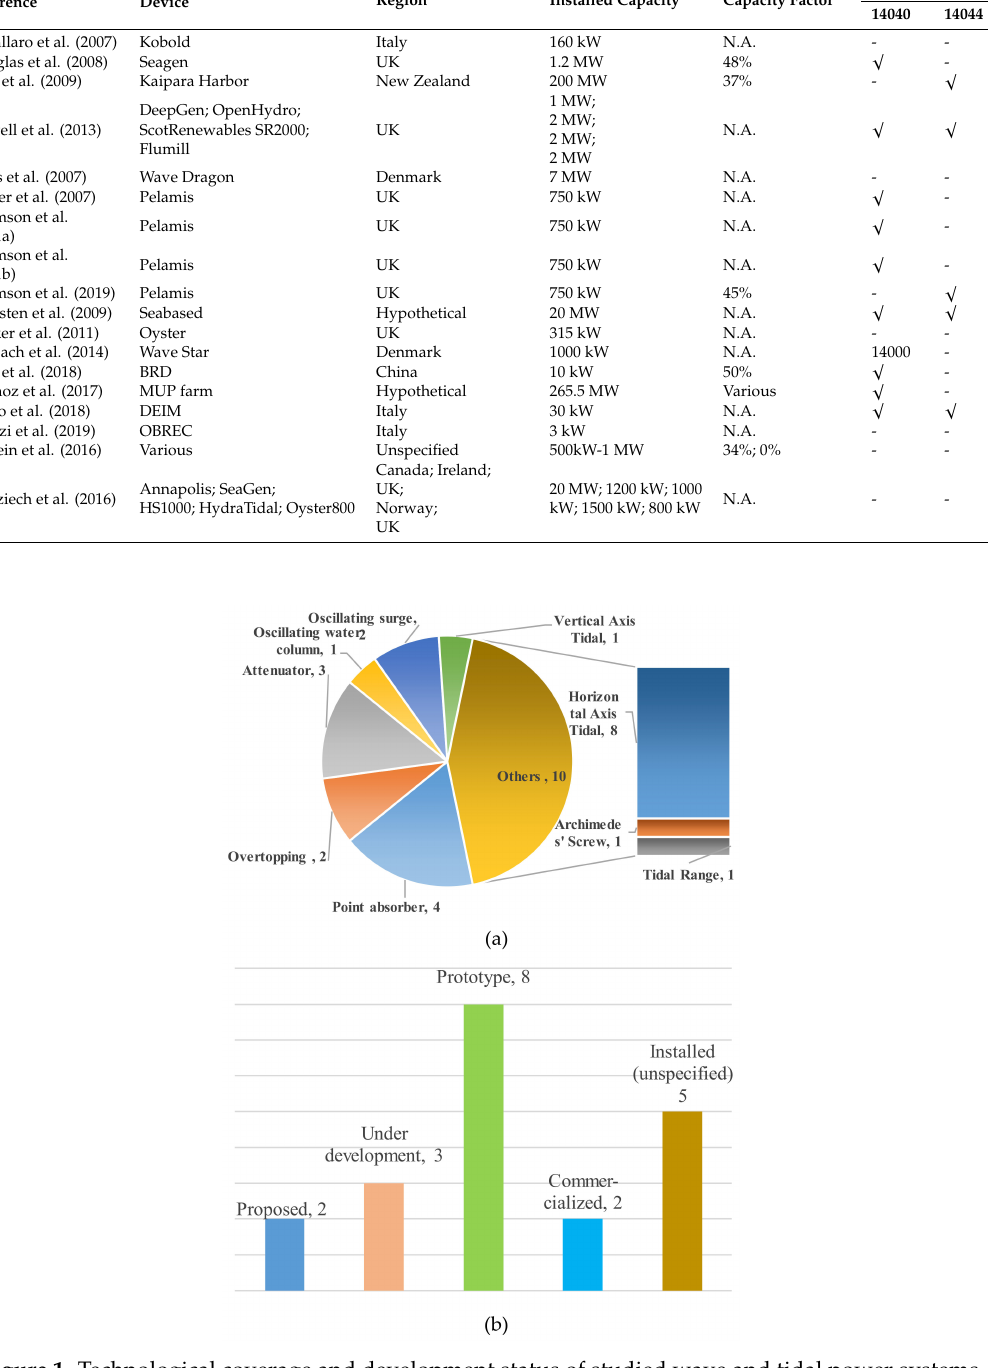
Figure 1. Technological coverage and development status of studied wave and tidal power systems. (a) Technological coverage; (b) Development status. Note: the number following each item in (a) indicates the number of the systems by specific type of technology; the number following each item in (b) indicates the number of the systems under the specific development